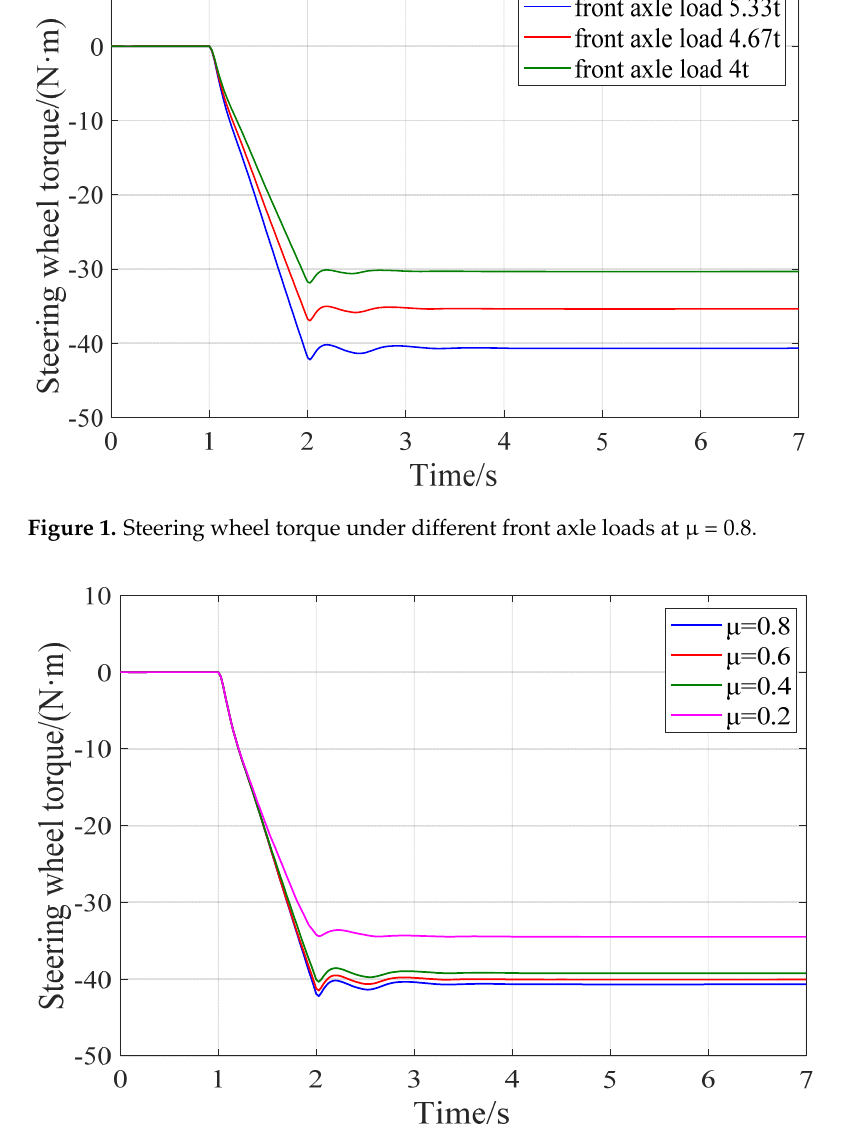
Figure 2. Steering wheel torque under different adhesion coefficients at front axle load 5.33 t. According to simulation results, steady-state values of steering wheel torque under different front axle loads and adhesion coefficients are shown as follows: 25.1 N·m at 4 t and µ = 0.2, 30.3 N·m at 4 t and µ = 0.8, 34.0 N·m at 4.67 t and µ = 0.4, 35.4 N·m at 4.67 t and µ = 0.8, 34.5 N·m at 5.33 t and µ = 0.2, 39.2 N·m at 5.33 t and µ = 0.4, 40.0 N·m at 5.33 t and µ = 0.6, and 40.7 N·m at 5.33 t and µ = 0.8. In addition, simulation results show that adhesion coefficient. The greater the front axle load is, the greater the road adhesion coef-